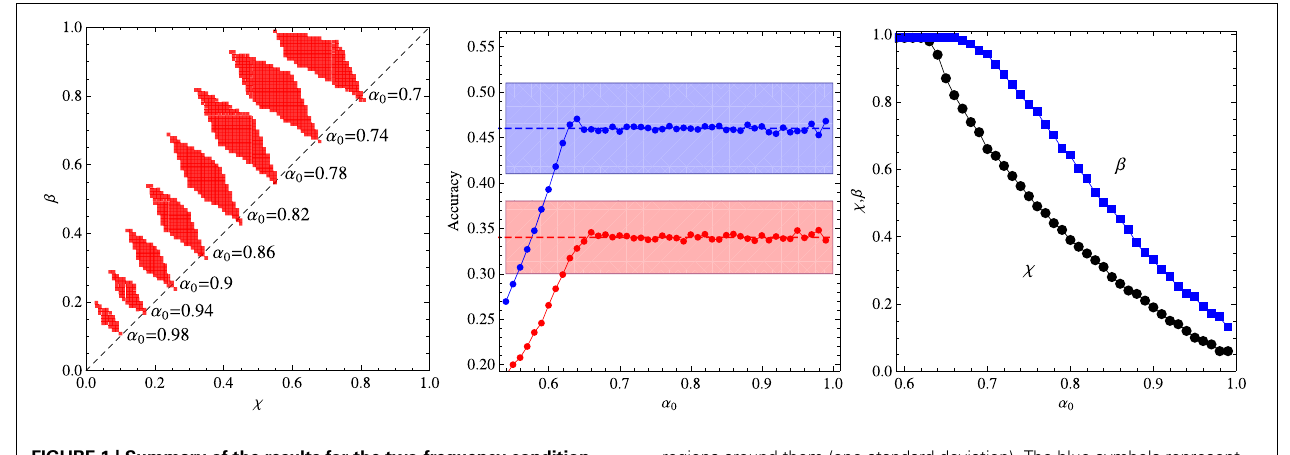
regions around them (one standard deviation). The blue symbols represent the accuracy for the group of words sampled 9 times whereas the red symbols represent the accuracy for the words sampled 3 times. Right panel: Parameters χ and β corresponding to the best fit shown in the middle panel. The other parameters are N = 18 and C =